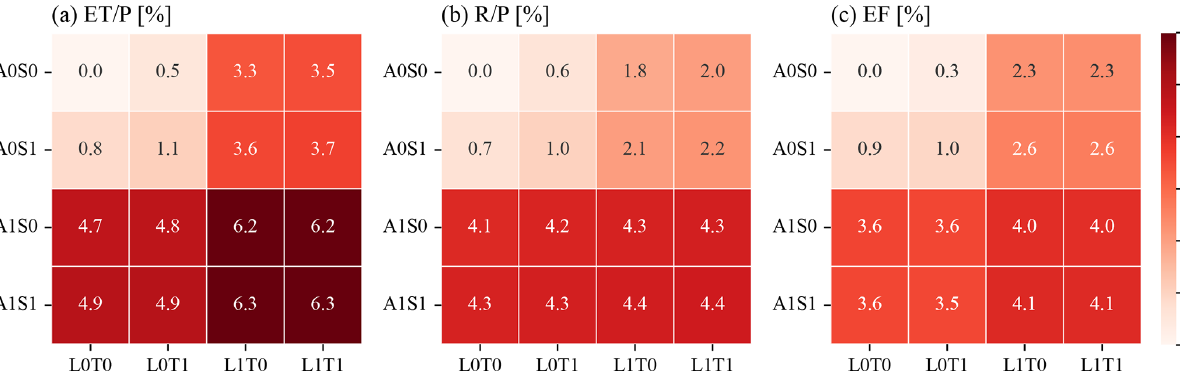
Figure 3. CONUS-averaged SD of the annual climatology of (a) ET /P , (b) R/P , and (c) EF. Combining the x axis label for LULC and TOPO and the y axis label for ATM and SOIL indicates the names of the experiments listed in Table 2, highlighting the use of heterogeneous (1) and homogeneous (0) inputs for each heterogeneity source.